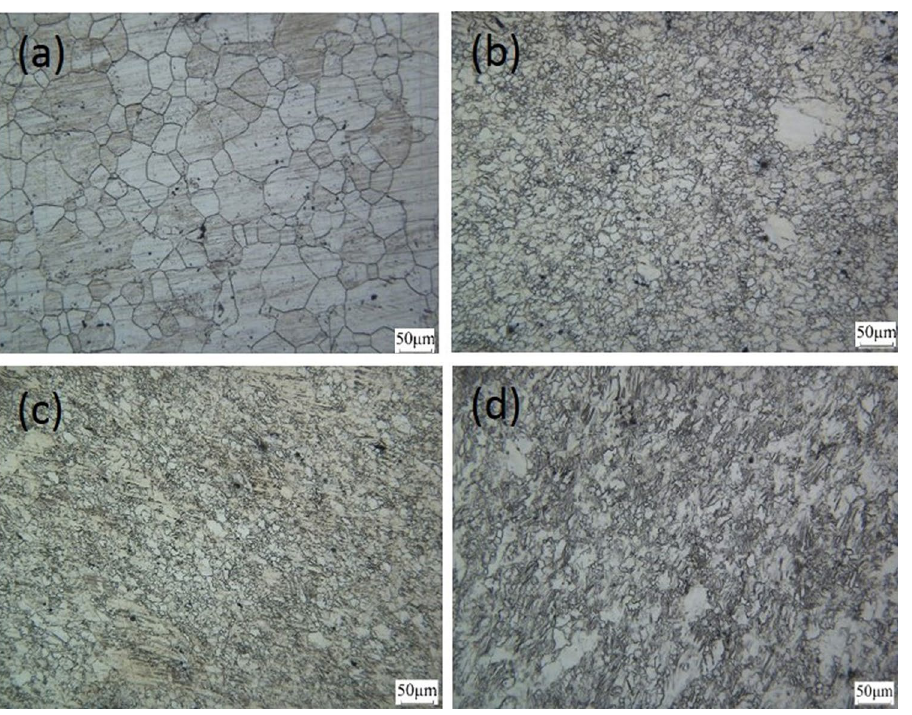
Figure 2. Microstructure of magnesium alloy in different states. ( a ) Homogenization, ( b ) ECAP4passes, ( c ) ECAP4Passes + room temperature rolling, ( d ) ECAP4Passes + liquid nitrogen rolling.